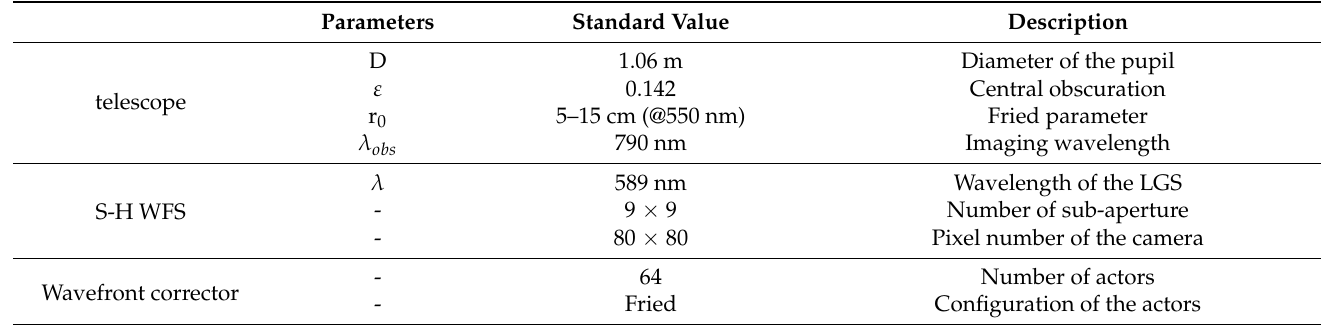
Table 1. Parameters of the telescope and the AO system.